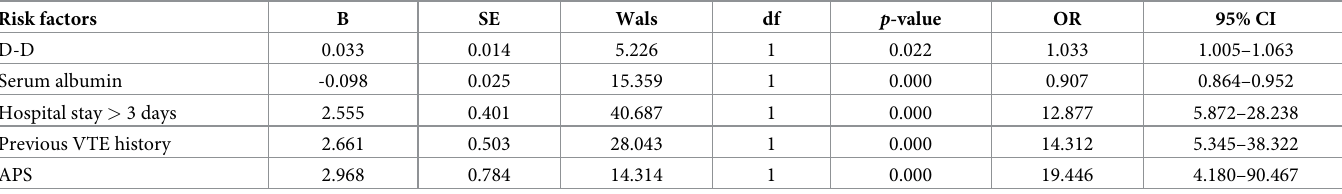
Table 4. Multivariate binary logistic regression analysis for VTE among the hospitalized rheumatic